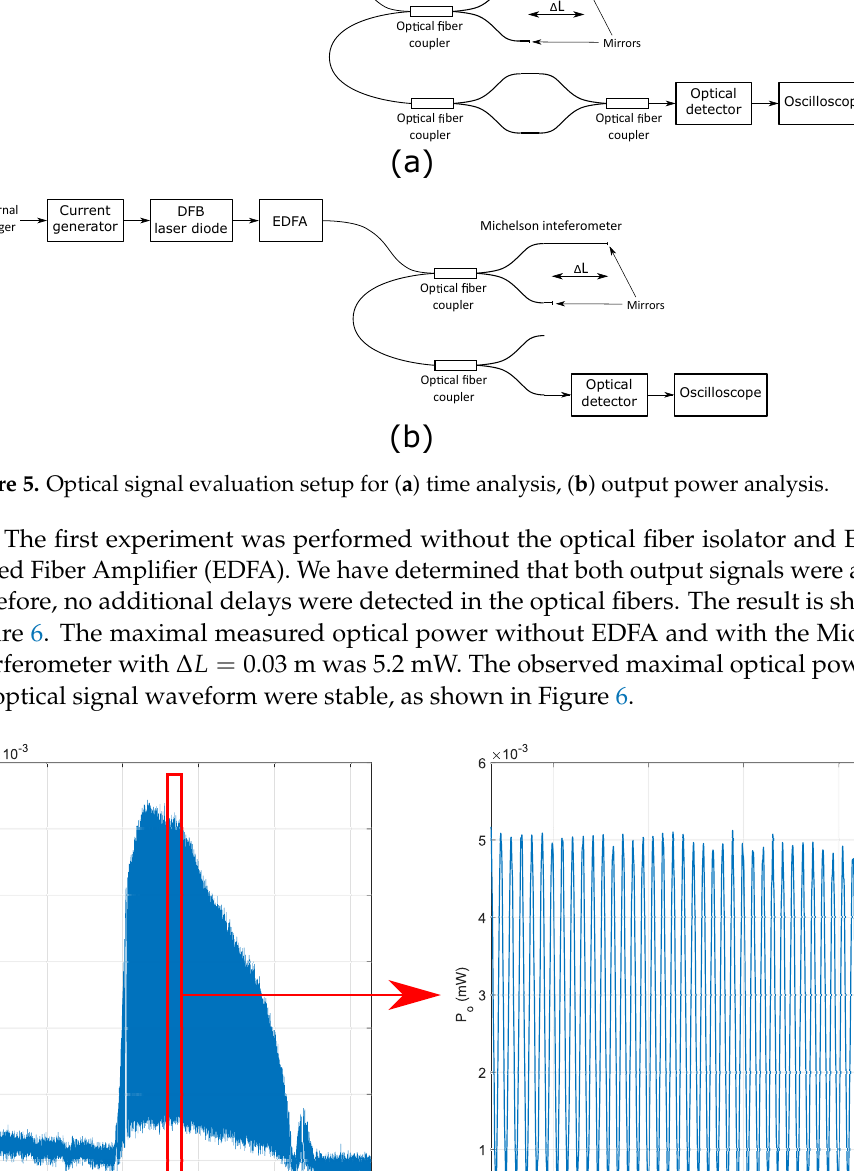
Figure 6. Generated optical signal without EDFA in the optical signal evaluation’s first experiment. An EDFA, optical fiber isolator, and Michelson interferometer with ∆ L = 0.03 m